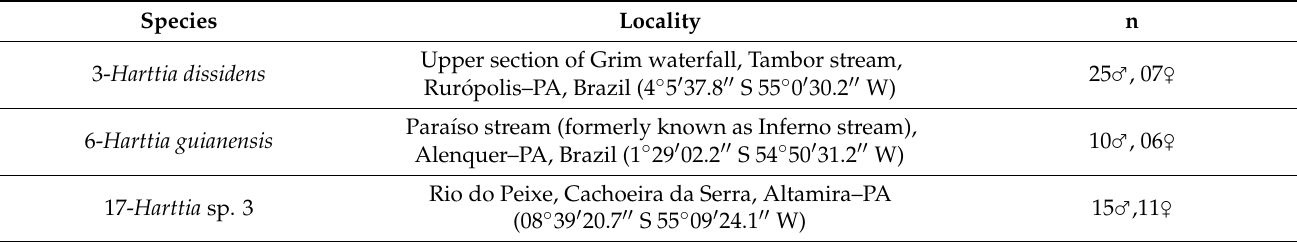
Figure 1. Brazilian territory (green), and the Harttia species cytogenetically analyzed in former reports [34–36,38] (white circles), including the present study (red circles). Each Harttia species is presented by a certain number; the table with the coding system is presented in the white frame on the right. Table 1. Geographic coordinates of the collection sites and the number of specimens per species analyzed in this study. The number codes placed before the species names correspond to the numbering system in Figure 1. Species Locality